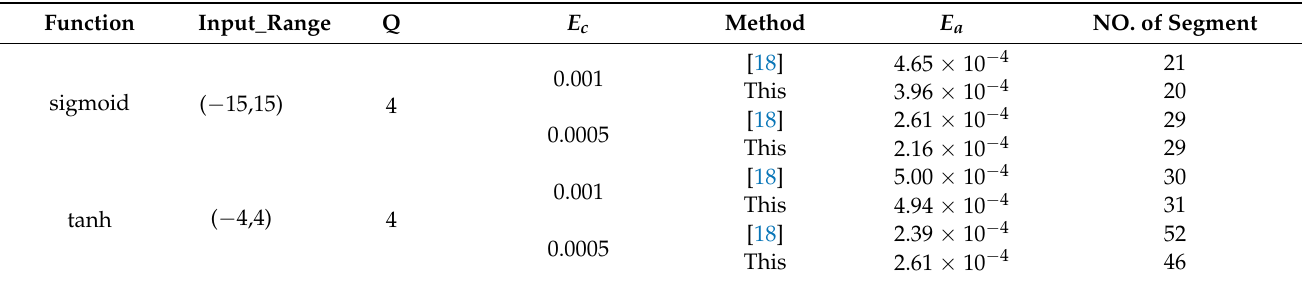
Table 1. Segment Approximation Comparison.